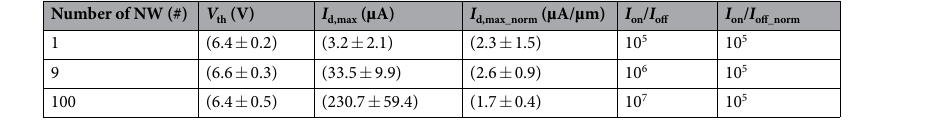
Table 1. DC characteristic results of vertical n-p-n GaN NW FETs (average value) with NW numbers of 1, 9, and 100 and a diameter of 440